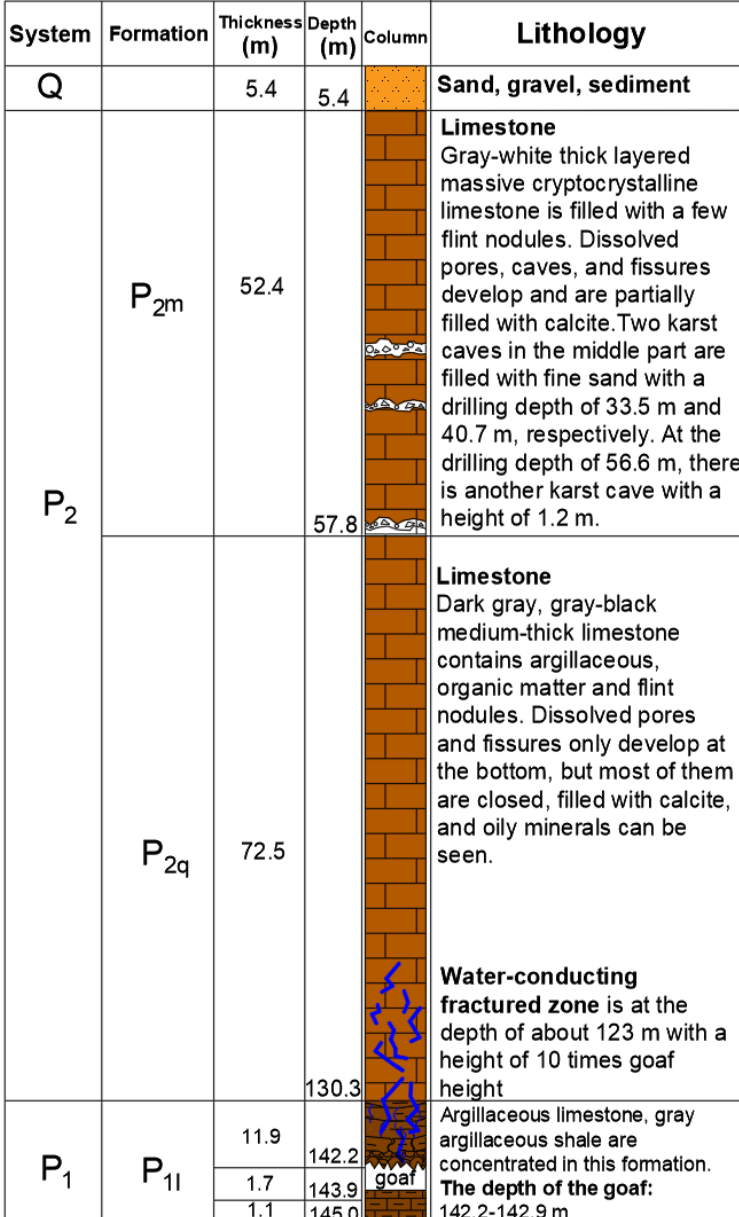
Figure 2. Stratigraphic column in borehole CK-1.